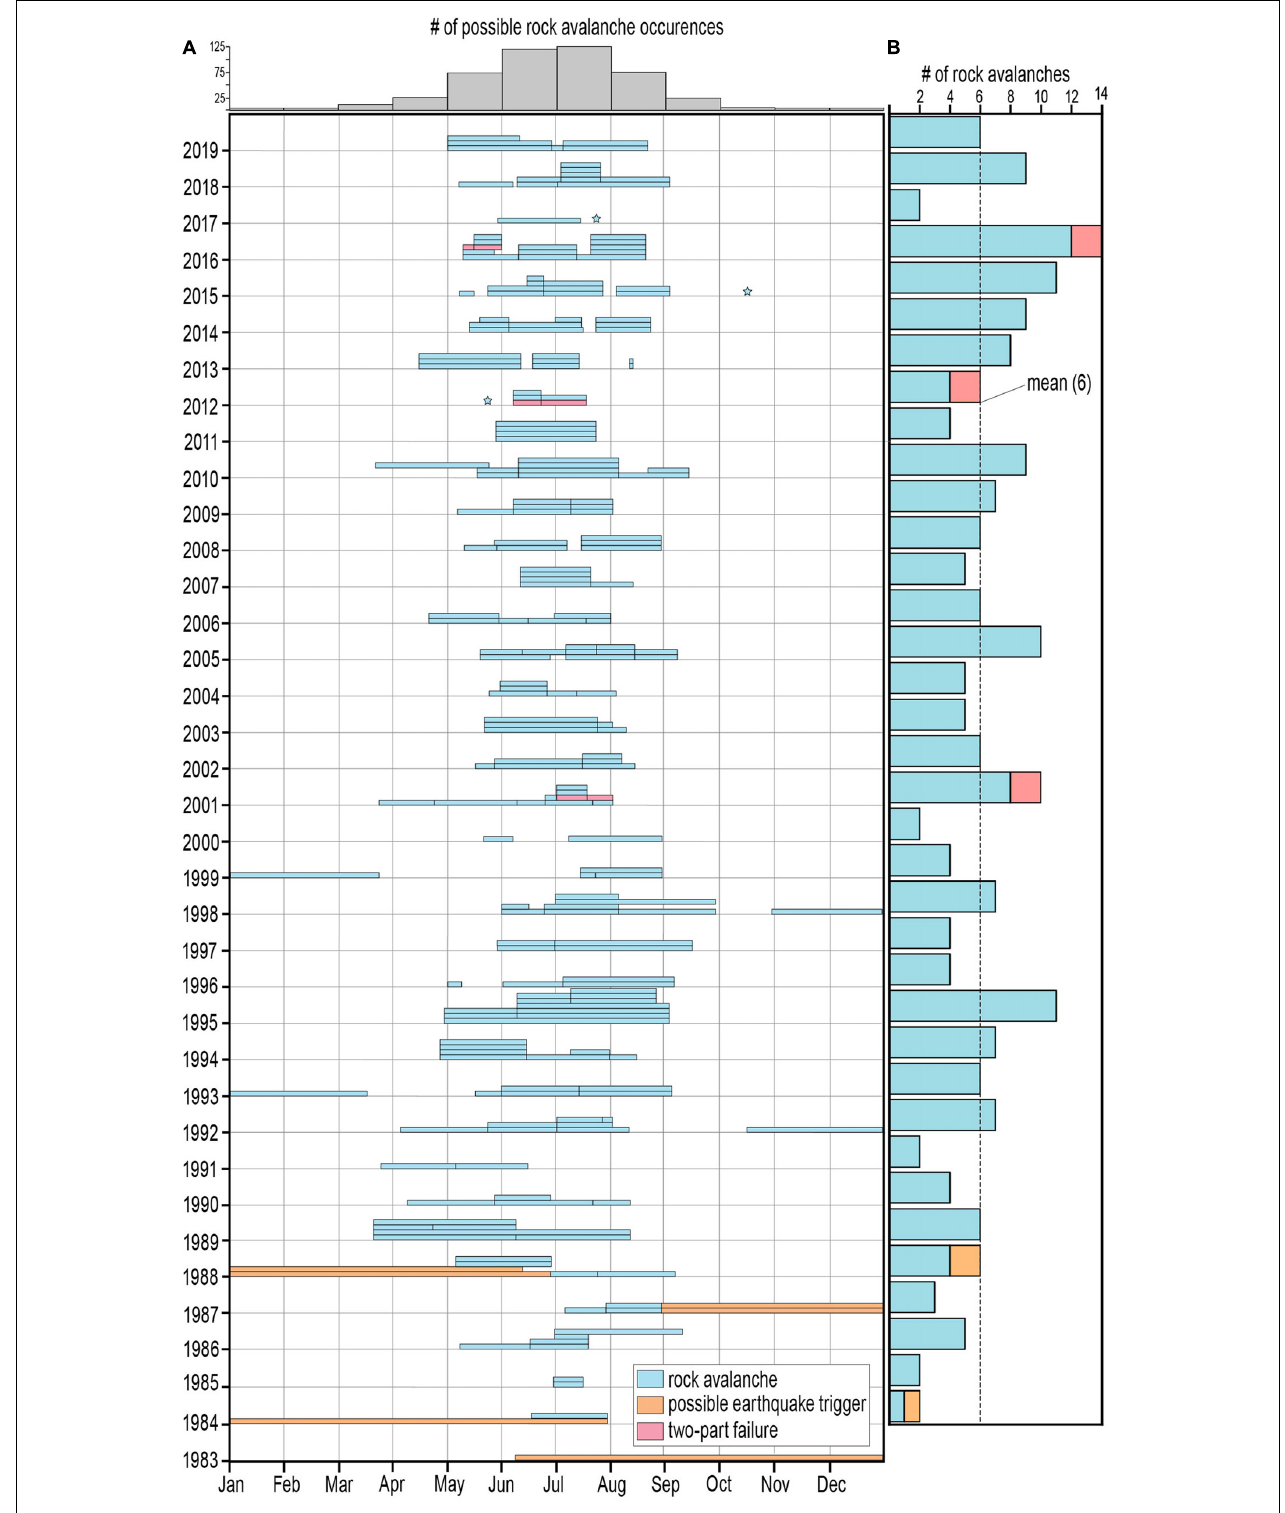
FIGURE 3 | (A) Chart showing the range of possible dates for 220 rock avalanches in the Saint Elias Mountains between 1984 and 2019 (center) and the number of possible rock avalanche events during each month of the year (top). Rock avalanches for which the exact event date is known are shown by stars. (B) Total number of rock avalanches that occurred annually during the period of record, with an overall mean of six rock avalanches per year.